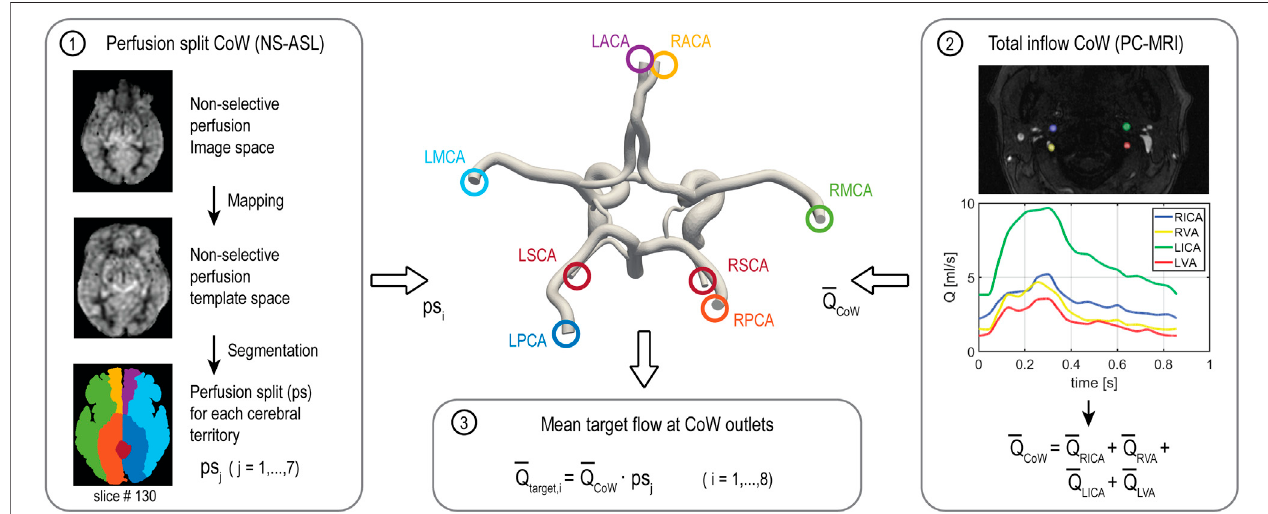
FIGURE 2 | Work fl ow of calculating the fl ow split among the arteries of the CoW based on NS-ASL perfusion imaging, a vascular territory atlas, and total in fl ow to the CoW from PC-MRI. RACA/LACA, right/left anterior cerebral artery; RMCA/LMCA, right/left middle cerebral artery; RPCA/LPCA, right/left posterior cerebral artery; RSCA/LSCA, right/left superior cerebellar